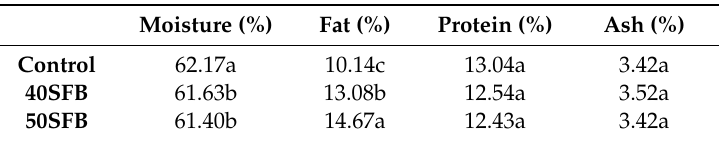
Table 2. Proximate composition of chicken sausages with di ff erent substitution level (%) of chicken skin by chicken fatty byproducts (40SFB: 40% substitution of chicken skin by fatty byproducts; 50SFB: 50% substitution of chicken skin by fatty byproducts).